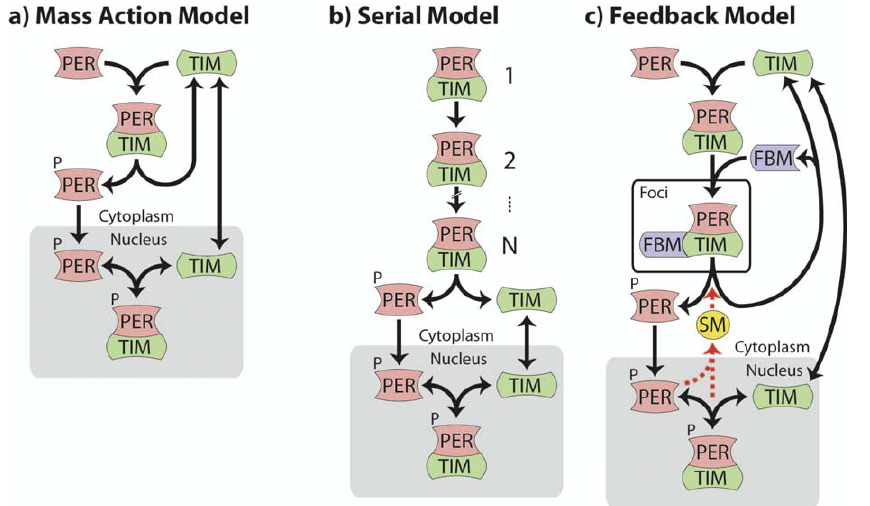
Figure 2. Models of the Isolated per / tim Loop (A) The simple mass action kinetics model. (B) The serial model is based on a series of intermediate (possibly phosphorylated) PER–TIM states. (C) The feedback model proposes a new role for PER providing positive feedback on the dissociation of cytoplasmic PER–TIM complexes.